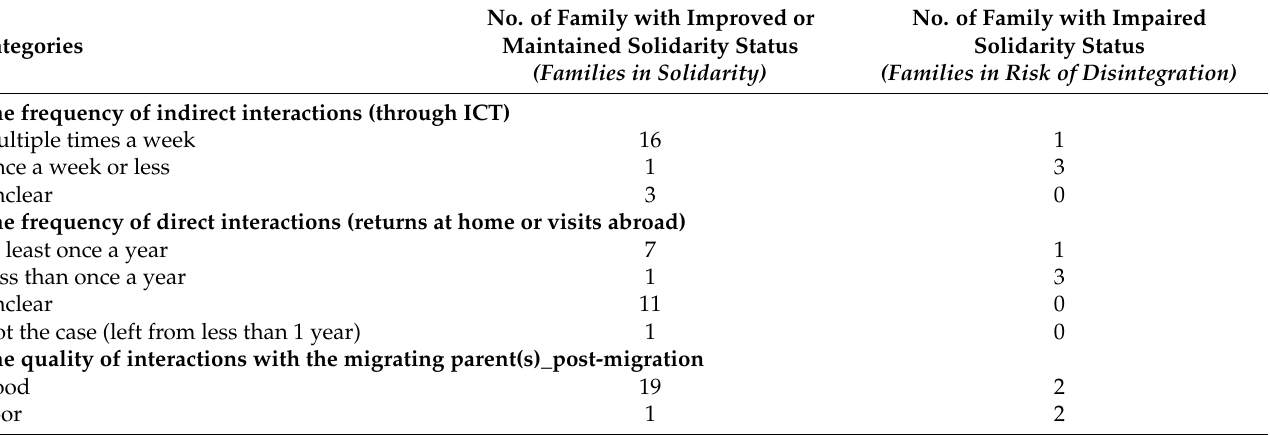
Table 3. The emotional support and the feeling of unity with the